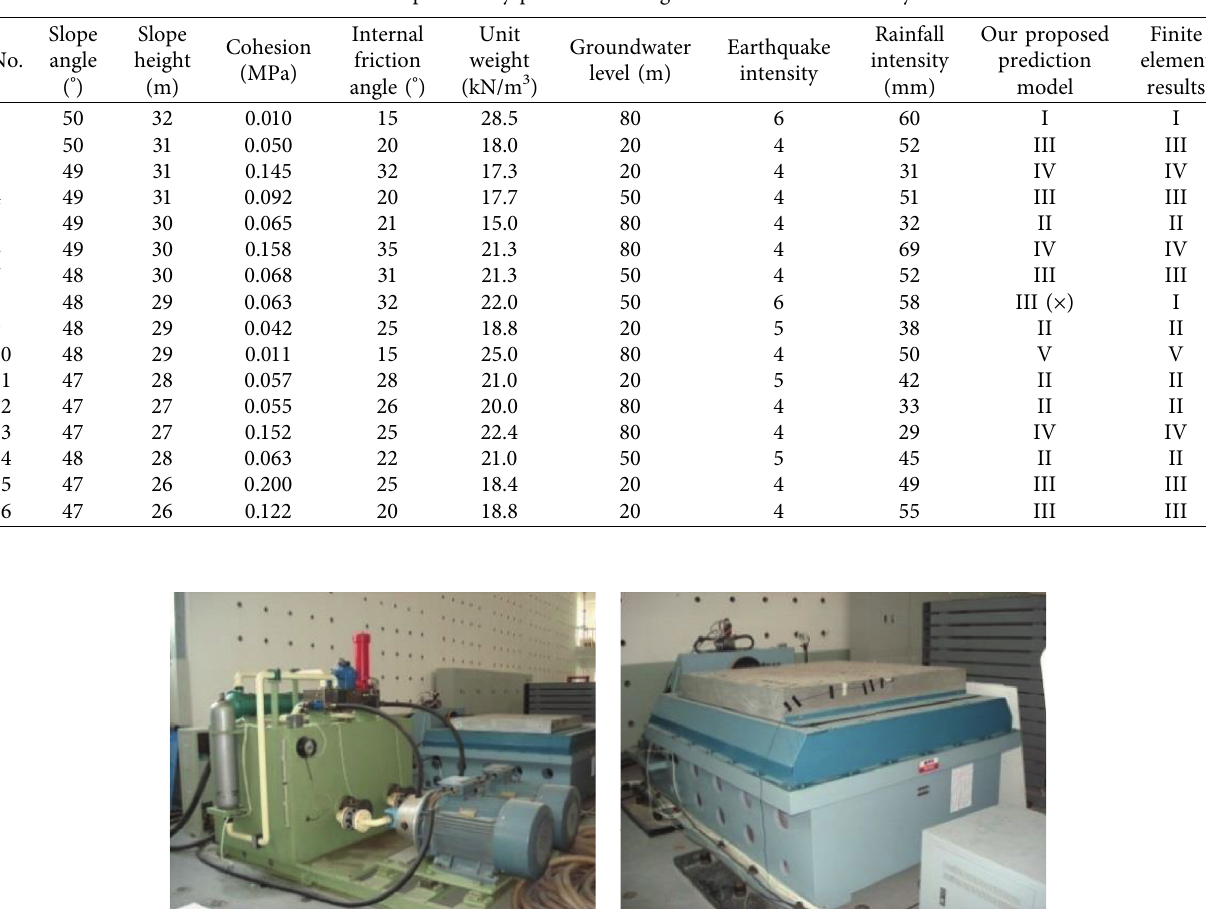
Table 6: Slope stability prediction along the Sichuan-Tibet railway.